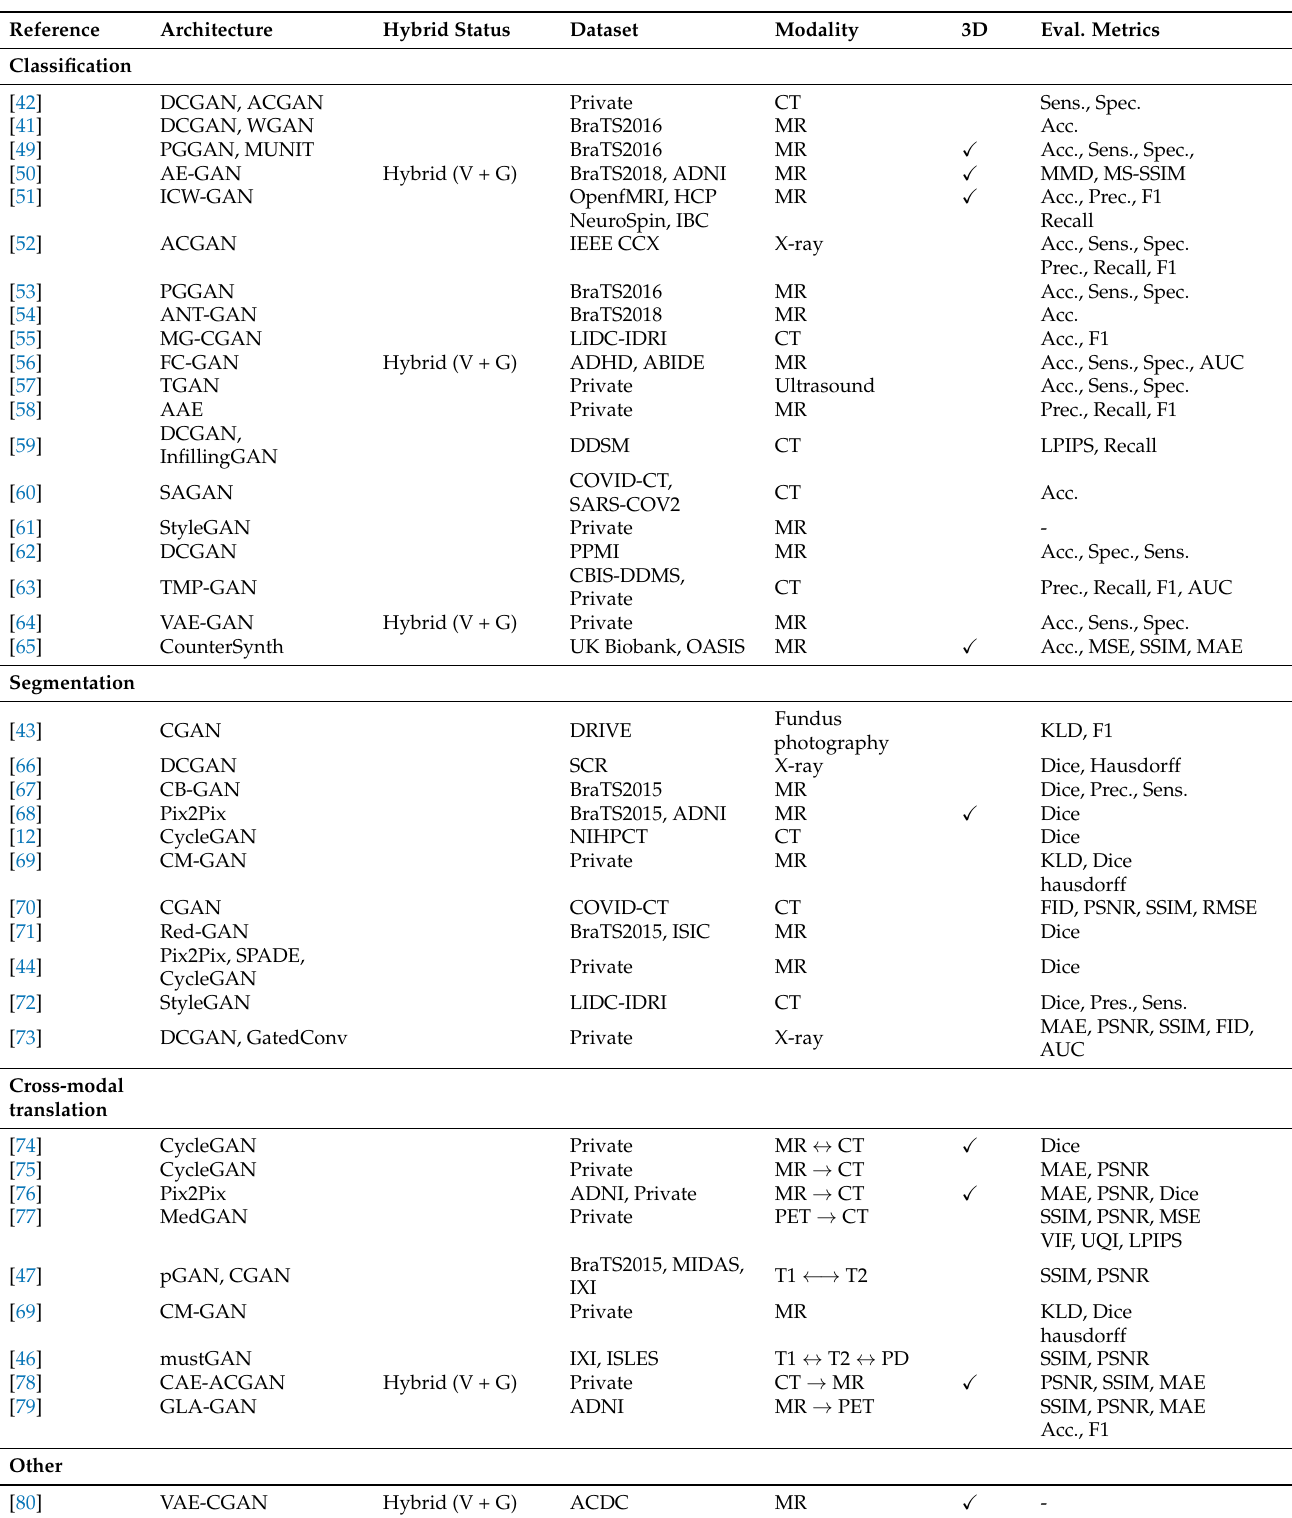
Table 1. Overview of GAN-based architectures for medical image augmentation, including hybrid status of architectures (if applicable), indicating used combinations of VAEs, GANs, and